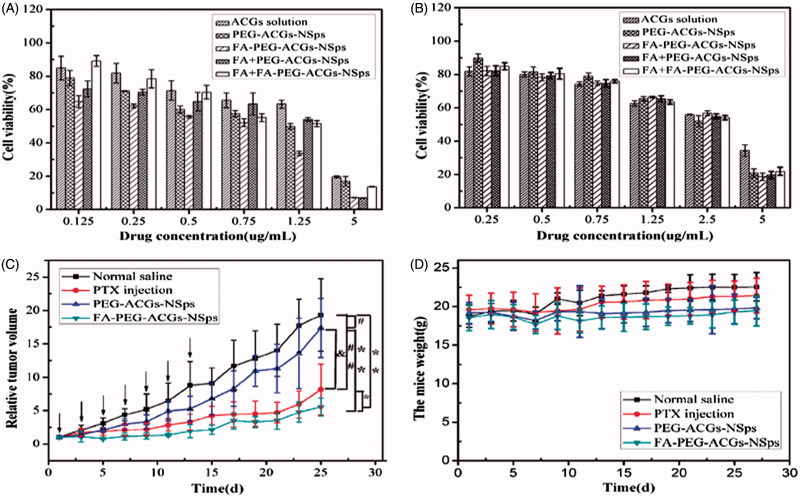
In vitro antiproliferative activity and in vivo antitumor experiments on HeLa tumor-bearing mice. (A) Cytotoxicity of ACGs solution, PEG-ACGs-NSps, FA-PEG-ACGs-NSps, FA + PEG-ACGs-NSps, and FA + FA-PEG-ACGs-NSps against HeLa cells (a) and A549 cells (b) for 24 h using MTT assay. All data are represented as mean ± SD (n = 6). (B) (a) The growth of relative tumor volume over time of PTX injections, PEG-ACGs-NSps, and FA-PEG-ACGs-NSps; (b) the average body weight change of mice along with time. All data are represented as mean ± SD. *p < .01, **p < .001 with FA-PEG-ACGs-NSps; &p < .01 with PEG-ACGs-NSps; #p < .01, ##p < .001 with normal saline. (C) The growth of relative tumor volume over time of PTX injections, PEG-ACGs-NSps, and FA-PEG-ACGs-NSps. (D) The average body weight change of mice along with time. All data are represented as mean ± SD. *p < 0.01, **p < 0.001 with FA-PEG-ACGs-NSps; &p < 0.01 with PEG-ACGs-NSps; #p < 0.01, ##p < 0.001with normal saline.